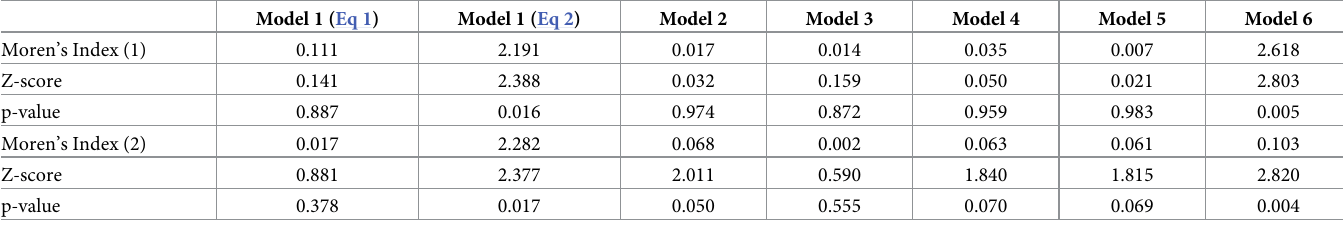
Table 6. Results from spatial autocorrelation statistics.